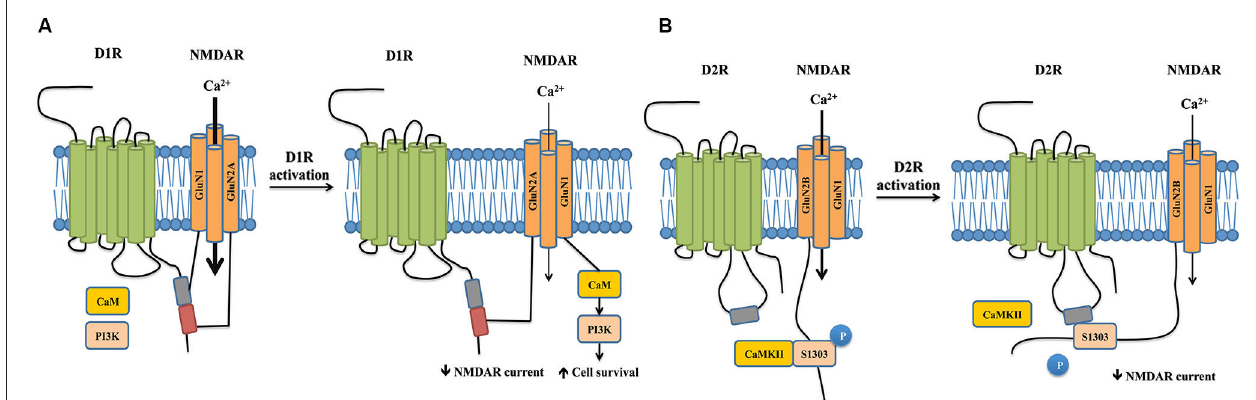
of D1R promotes the dissociation of GluN1 and D1R. This allows the recruitment of CaM and PI3K to GluN1, which activate PI3K-dependent cell survival signals and promote cell survival. (B) The carboxyl tail of GluN2B binds to the third intracellular loop of the D2R. Activation of D2R promotes its association with GluN2B, which in turn disrupts the binding between GluN2B and CaMKII. This leads to a decrease in CaMKII activity, resulting in reduced phosphorylation of Serine1303 of GluN2B and hence reduced NMDAR